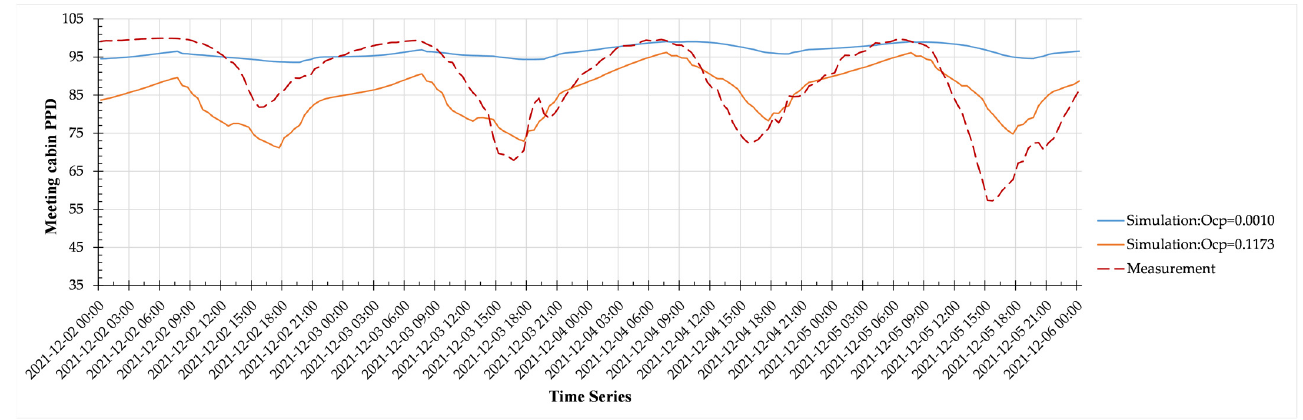
Figure B2. Meeting cabin: predicted percentage dissatisfied between 2 and 5 December 2021.